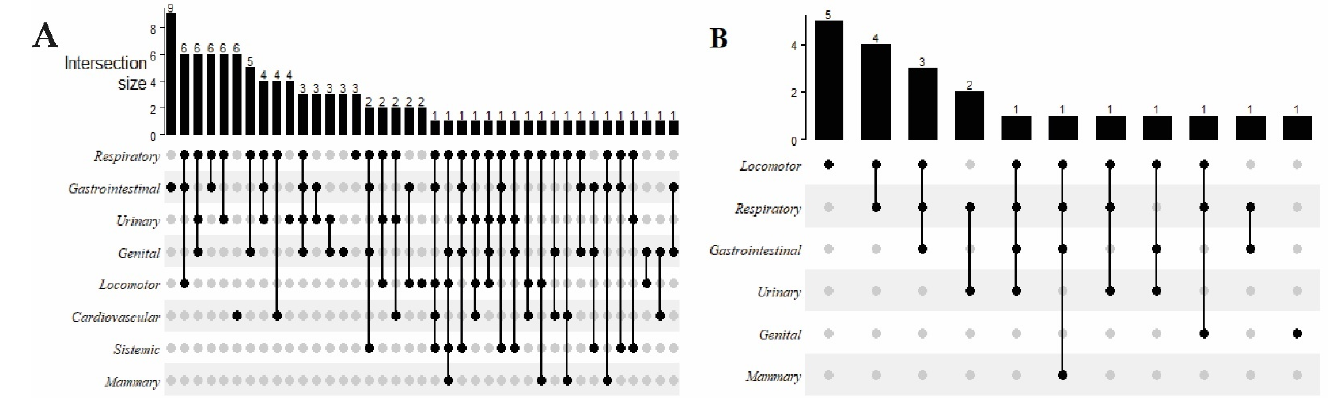
Figure 2. The number of females and post-mortem findings associated with spontaneous death ( A ) and with euthanized females ( B